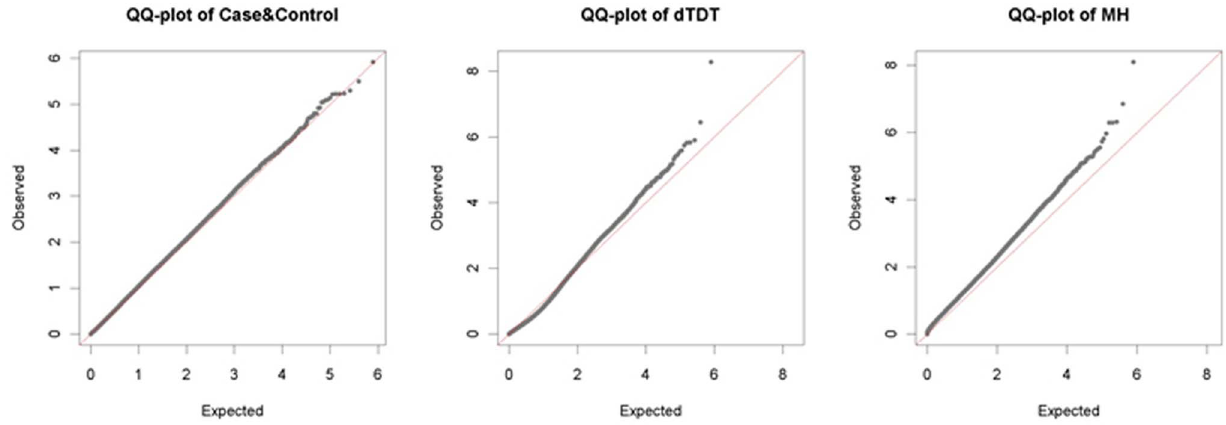
Figure 7. QQ-plots of Case-Control, dTDT and MH tests.